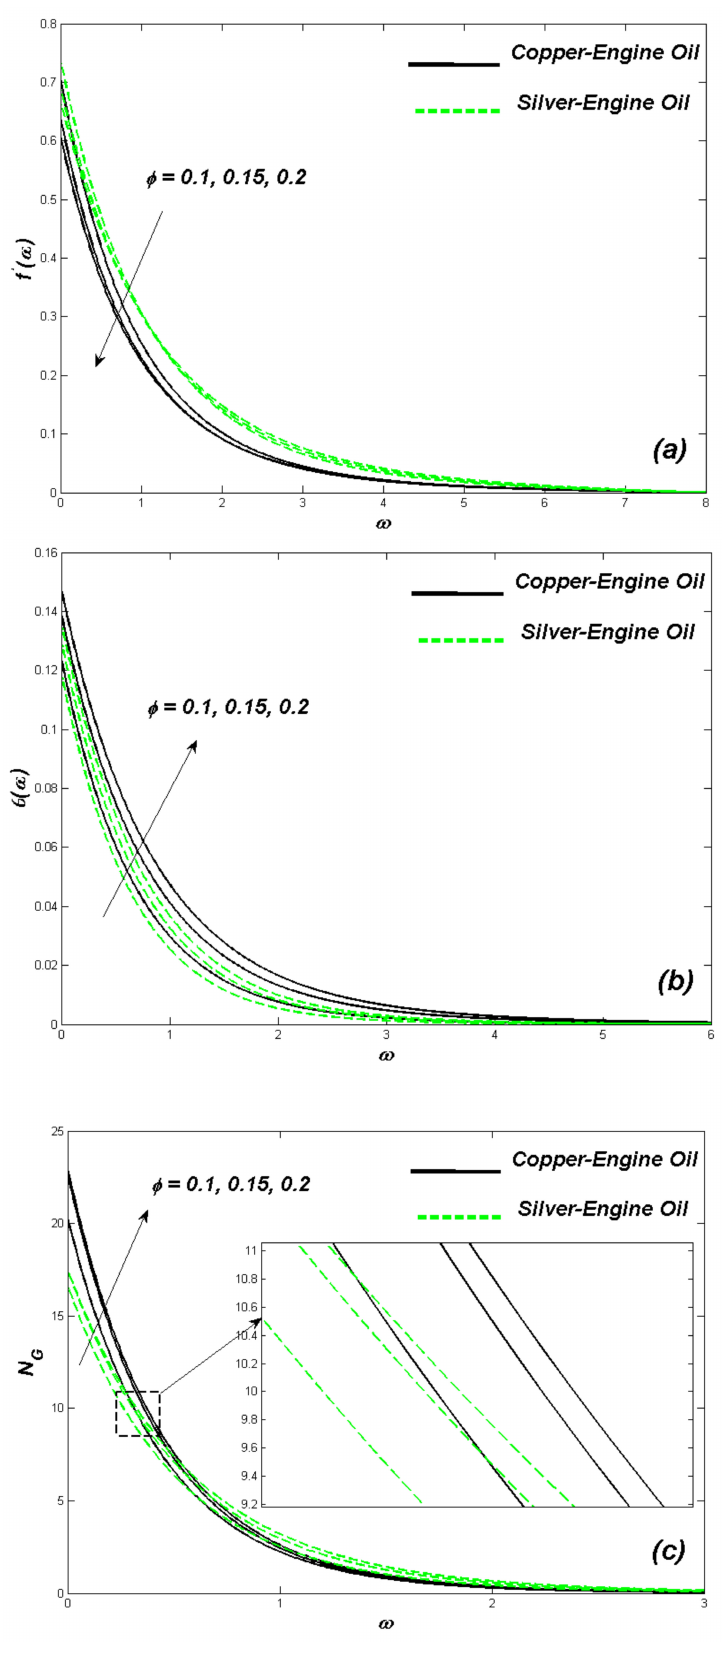
Figure 5. ( a ) Velocity change with φ . ( b ) Temperature change with φ . ( c ) Entropy change with φ